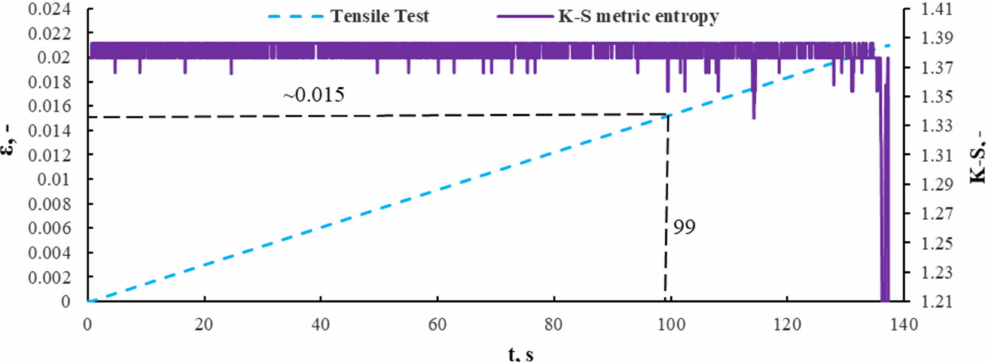
Figure 12. A metric entropy diagram applied on a strain diagram in the function of time, for a composite sample with a 10% recyclate content and ≤ 1.2 mm in mesh size.